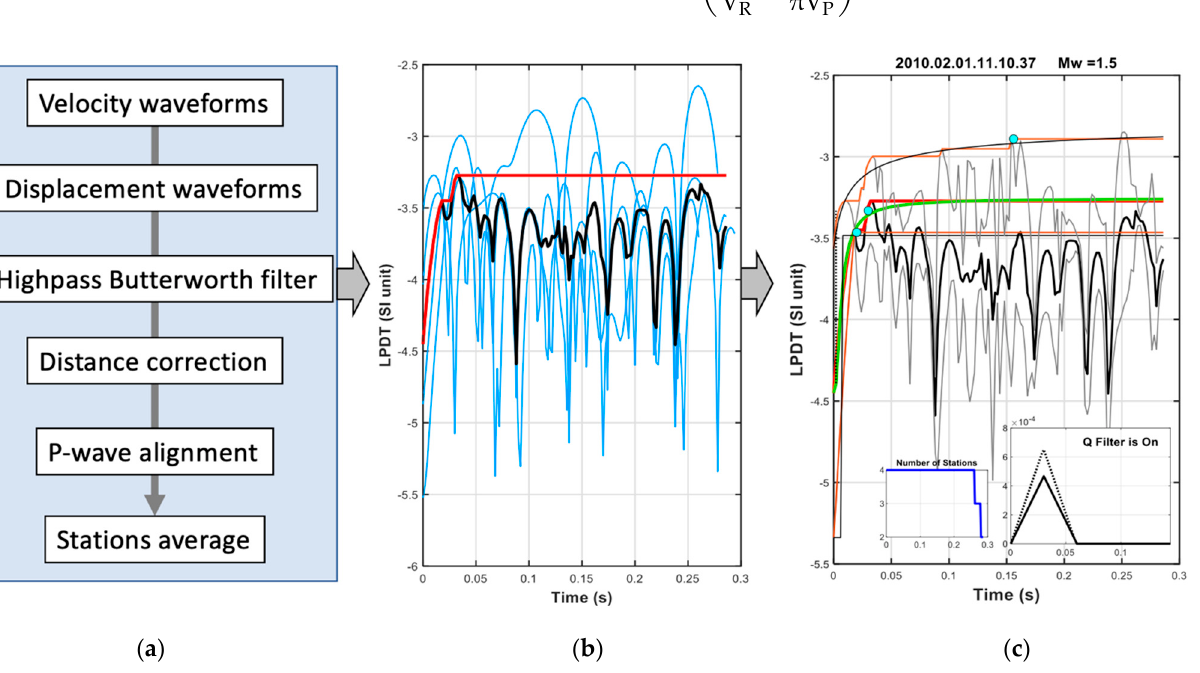
Figure 2. ( a ) Working diagram for LPDT curve creation. After the integration of raw data (velocity waveforms) to get displacement waveforms, they were high-pass Butterworth filtered (f c = 0.5 Hz). Then, every station curve was corrected by hypocentral distance, aligned with reference to the first P-wave arrival time, and then averaged to obtain the LPDT event curve; ( b ) The blue lines represent station curves; the solid black line is the average of station curves; and the solid red curve is the LPDT curve for one event; ( c ) The orange curves are the ± 1-sigma curves with respect to the red solid curve; the blue cyan circles refer to T c ; and the green line is the theoretical curve obtained with the retrieved T c and PL. The bottom panels show the decrease in the number of stations with respect to the chosen time window (left bottom panel) and the triangular source time function built before (solid black line) and after (dashed black line) the Q-correction of T c and PL (right bottom